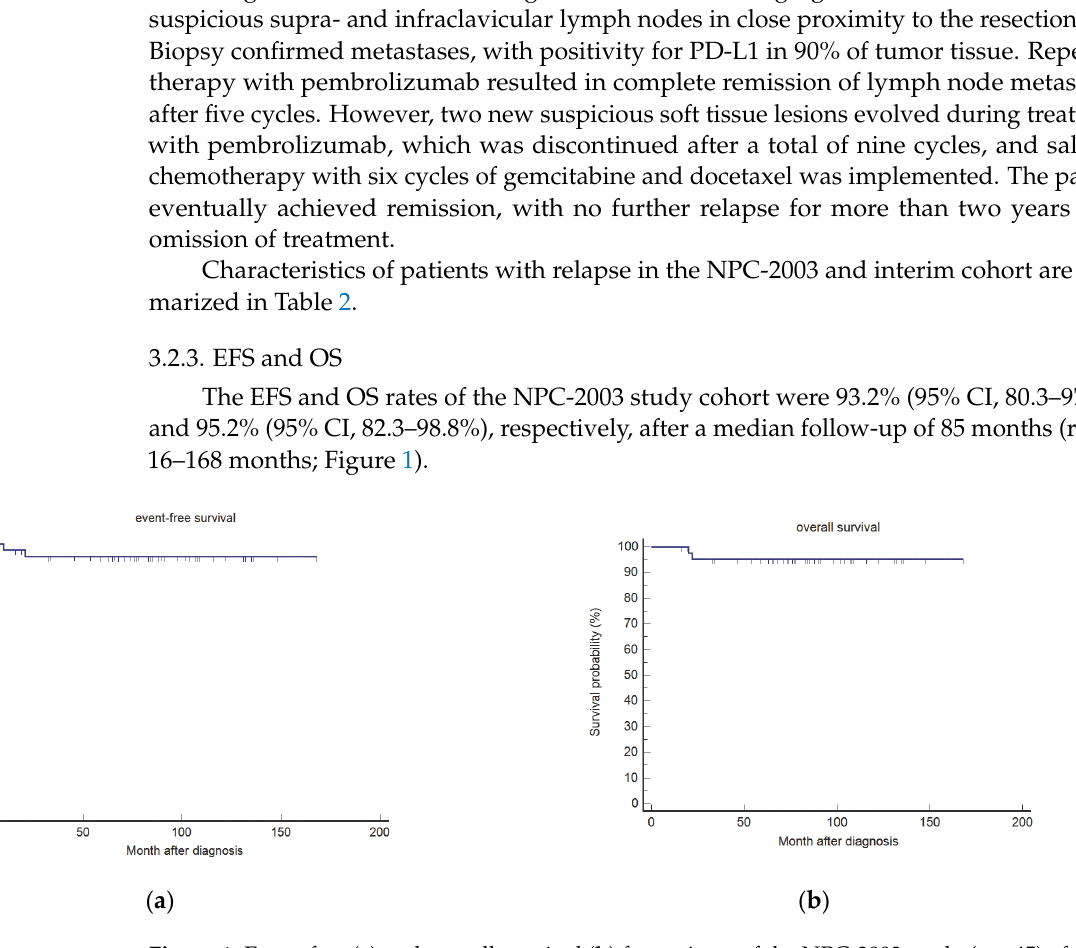
Figure 1. Event-free ( a ) and overall survival ( b ) for patients of the NPC-2003 study ( n = 45) after the extended median follow-up of 85 months.